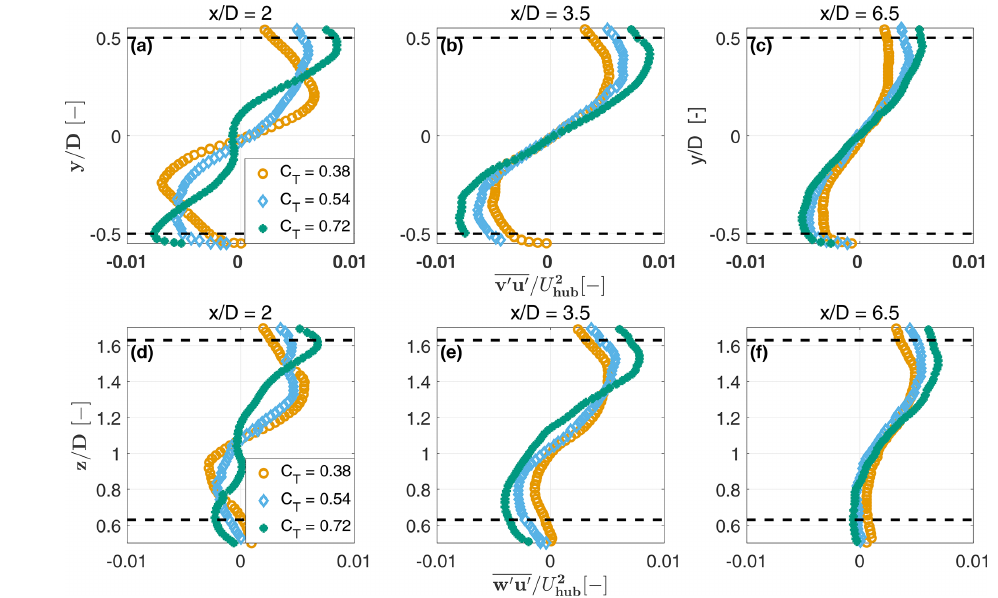
Figure 22. Horizontal (a–c) and vertical (d–f) profiles of the normalized lateral and vertical turbulent fluxes at several downstream distances and for different thrust coefficients, in the sheared turbulent UTD-HT inflow. Black dashed lines indicate the rotor tips.